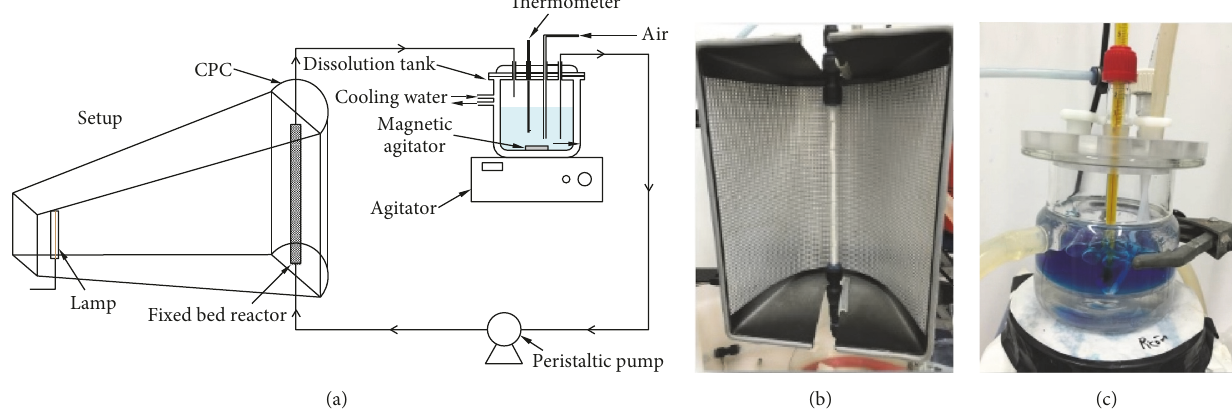
Figure 5: (a) Fixed-bed photoreactor scheme. (b) Fixed-bed reactor. (c) Wastewater photoreactor tank.